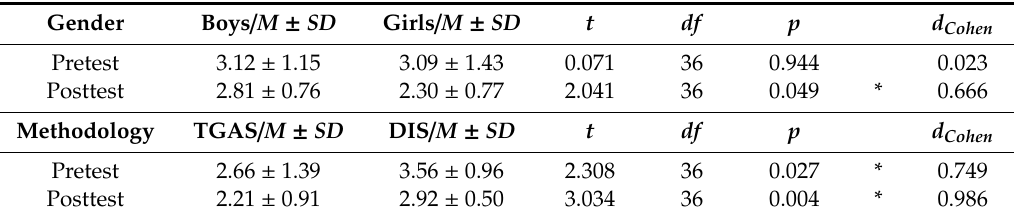
Table 5. Results of the RPE scale in the assessment tests according to gender and teaching methodology. Gender Boys / M ± SD Girls / M ± SD t df p d Cohen Pretest 3.12 ± 1.15 3.09 ± 1.43 0.071 36 0.944 0.023 Posttest 2.81 ± 0.76 2.30 ± 0.77 2.041 36 0.049 * 0.666 Methodology TGAS / M ± SD DIS / M ± SD t df p d Cohen Pretest 2.66 ± 1.39 3.56 ± 0.96 2.308 0.027 0.749 Posttest 2.21 ± 0.91 2.92 ± 0.50 3.034 36 0.004 *